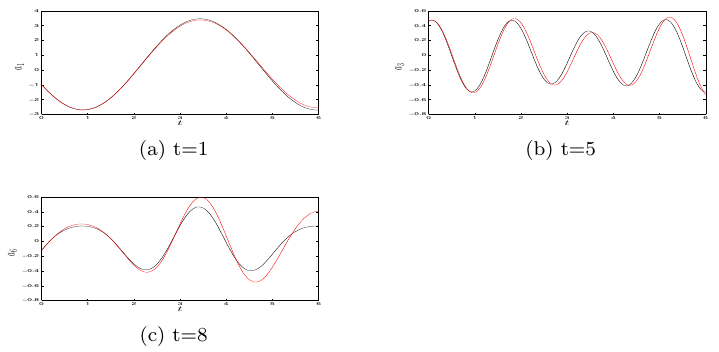
corresponds to twice the energy s = (cid:80) N s λ j ). j =1 s